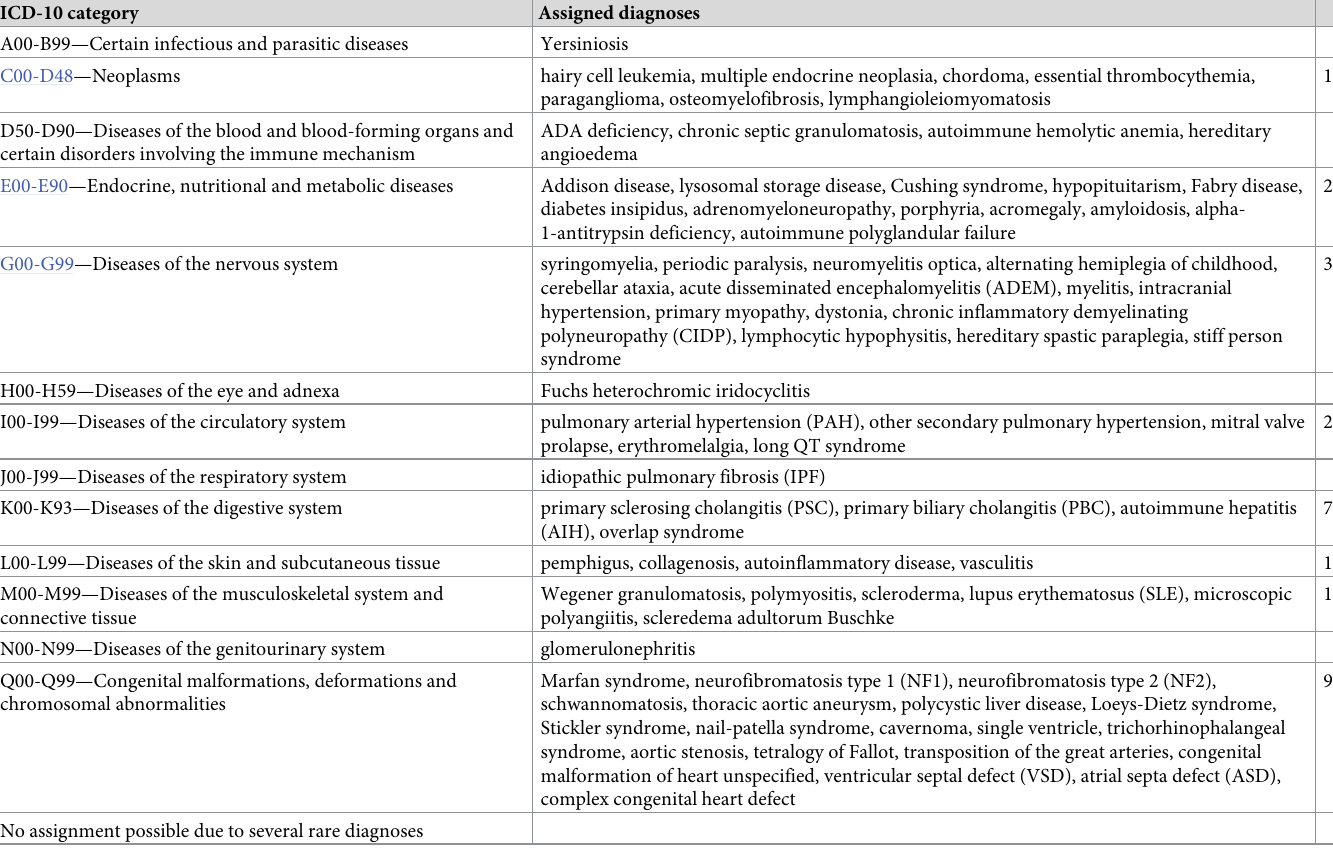
Table 1. Diagnoses assigned to ICD-10